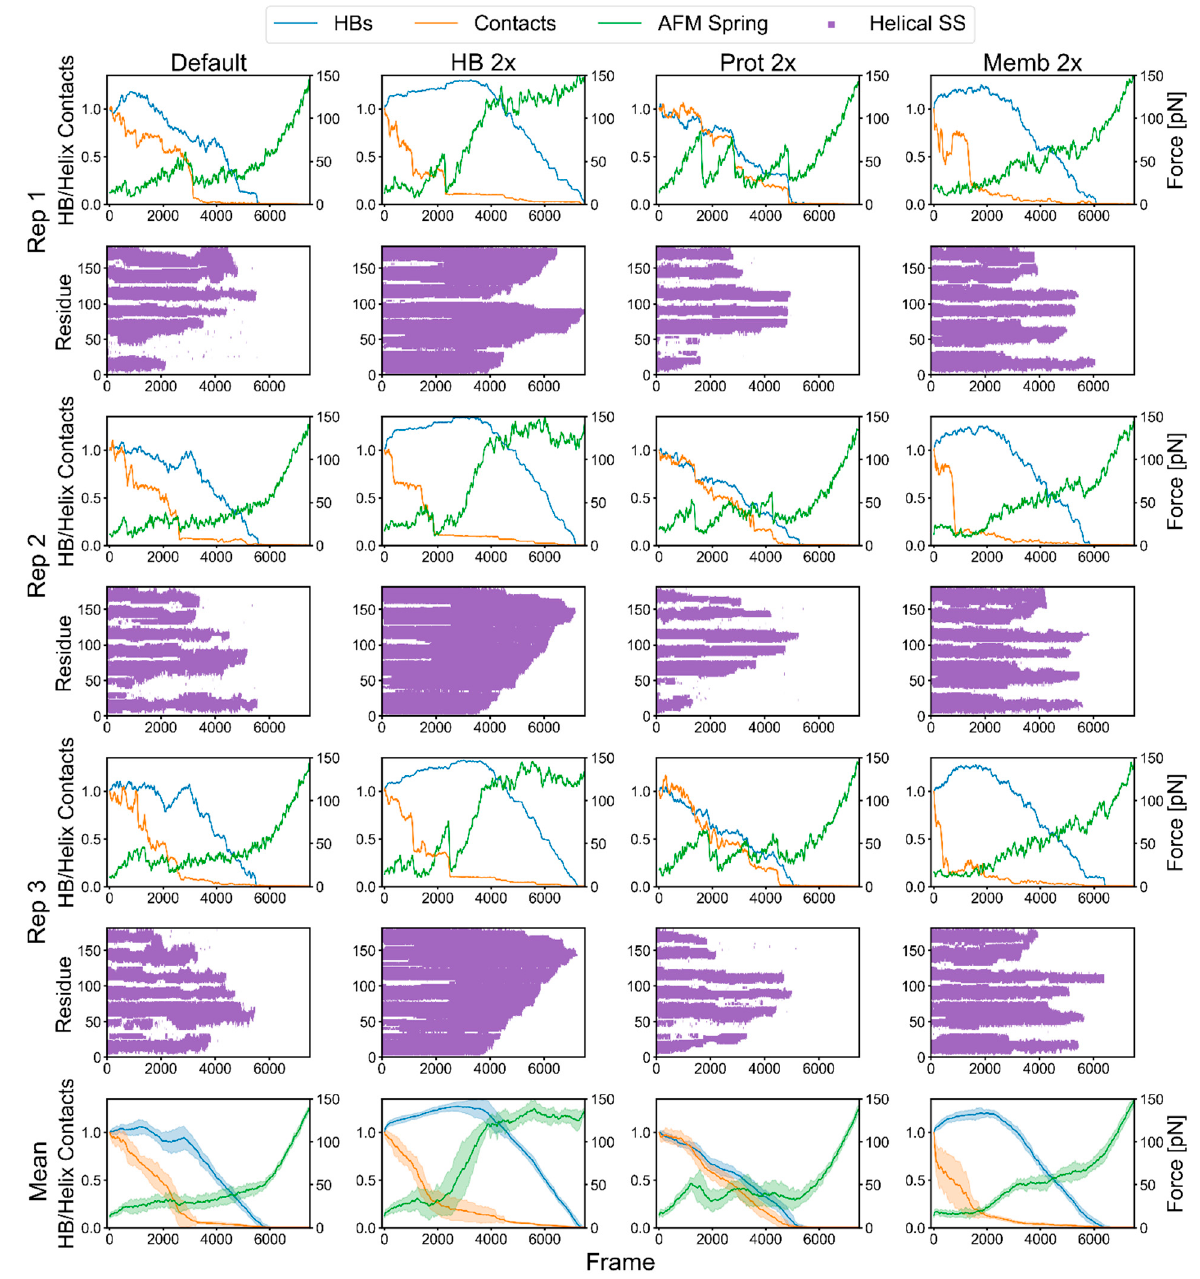
Figure 9. Effects of doubling each of the major energy terms on the lateral pulling of GlpG. The interaction and force plots for each replica are accompanied by a timeline of helical structure below (purple bars). Columns are forcefield conditions and rows are replicas. First column: standard forcefield; second: H-bond energy doubled; third: non-HB potential doubled; fourth: protein– membrane potential doubled. Last row are the average results of 28 replicas.